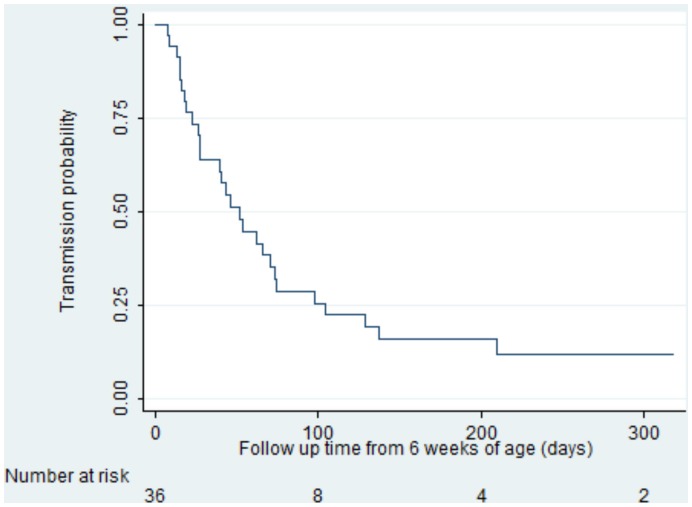
Kaplan-Meier curve showing transmission probabilities after 6 weeks of age.